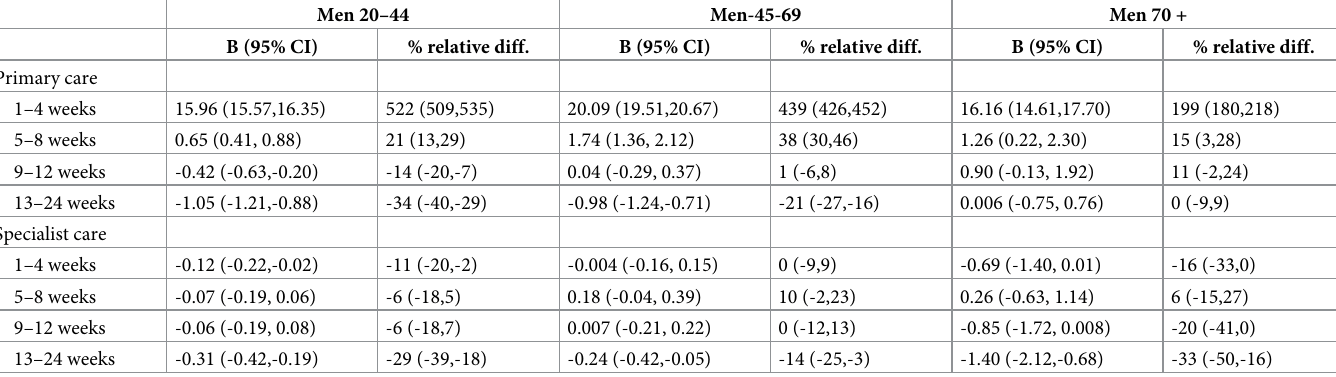
Table 4. Difference-in-differences (DiD) estimates of impacts of COVID-19 on health care use from 12–1 weeks before PCR test for SARS-CoV-2 to 1–4, 5–8, and 9–12 weeks after as well as 13–24 weeks after PCR